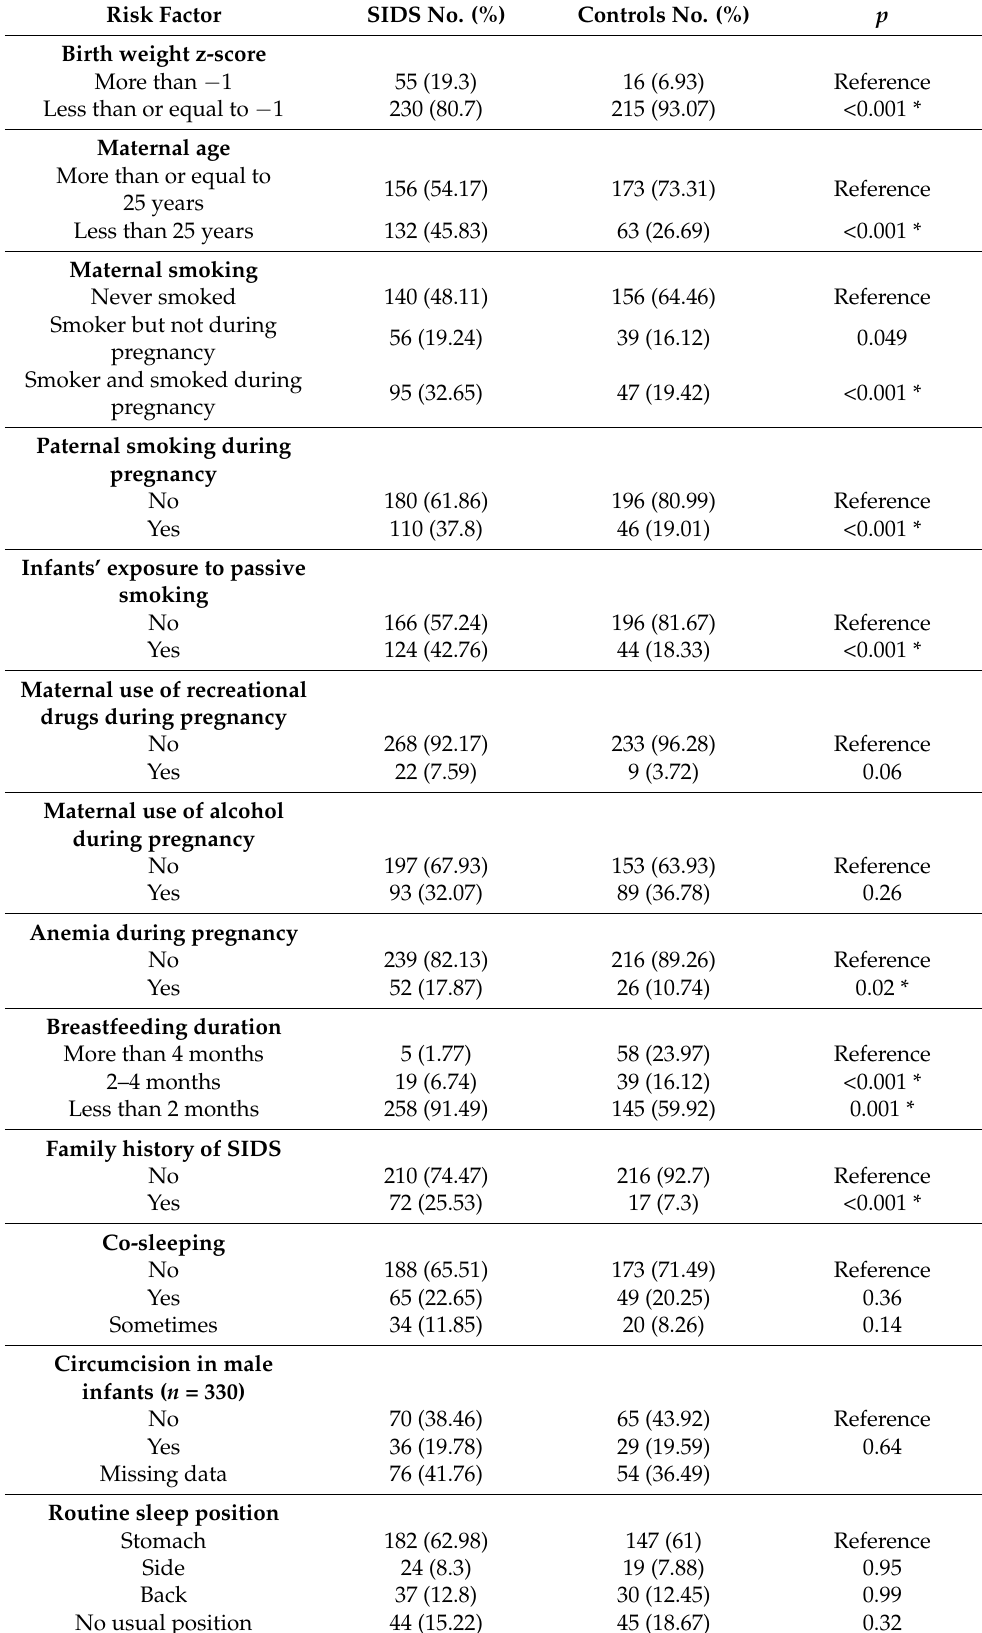
Table 3. Risk Factors Associated with